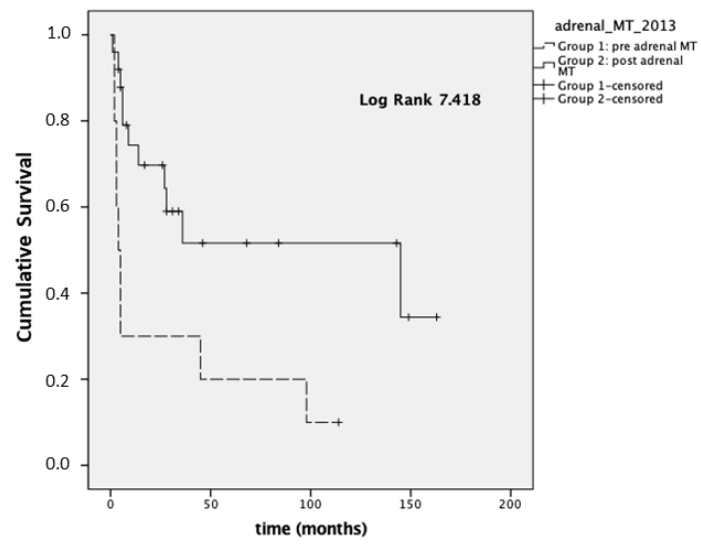
Figure 1. Overall survival (OS) in stages III–IV.